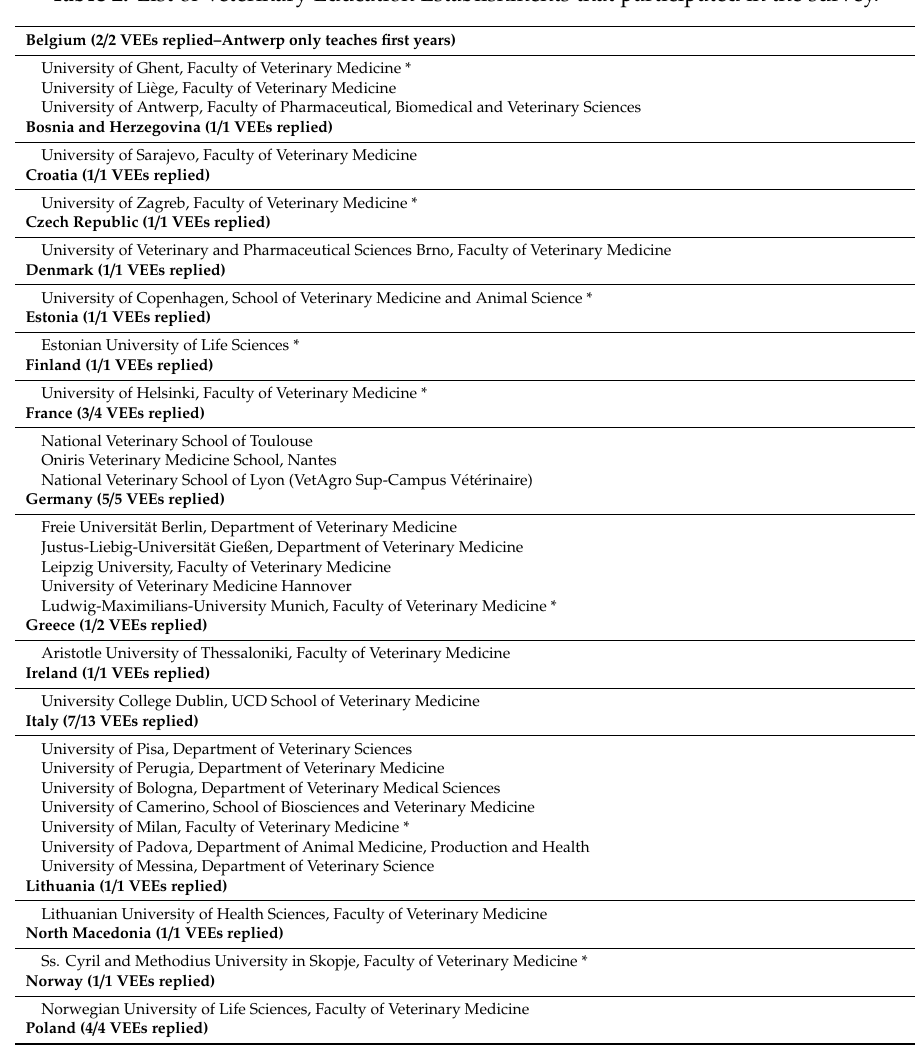
Table 2. List of Veterinary Education Establishments that participated in the